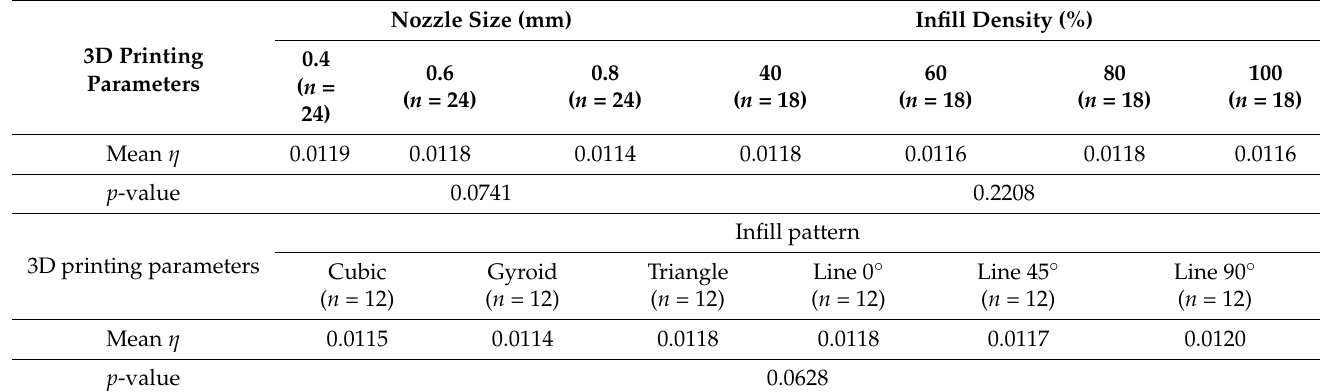
Table 4. ANOVA results for process parameters and loss factor ( n represents the sample